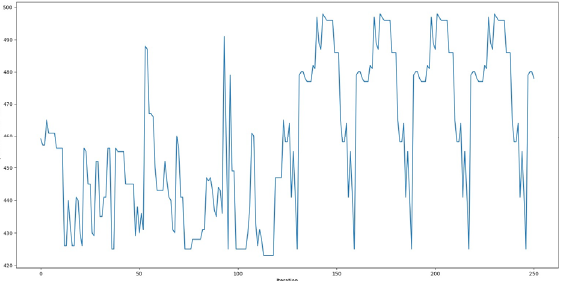
Fig. 10. Final solution of the algorithm with packing considerations (Instance